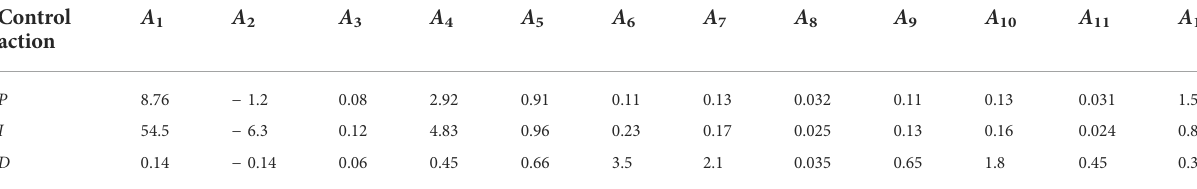
TABLE 2 Adaptive PID controller model coef fi cients A i for proportional, integral and derivative gains.